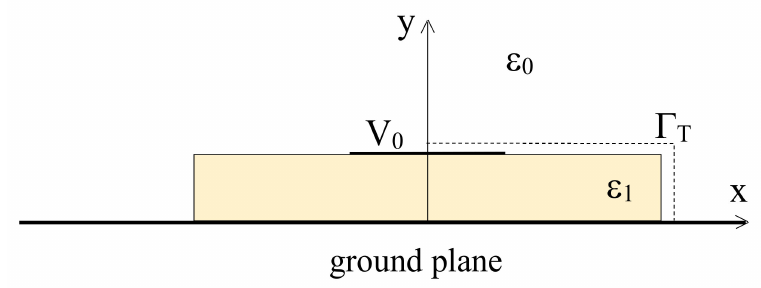
Figure 4. Microstrip line over a ground plane.